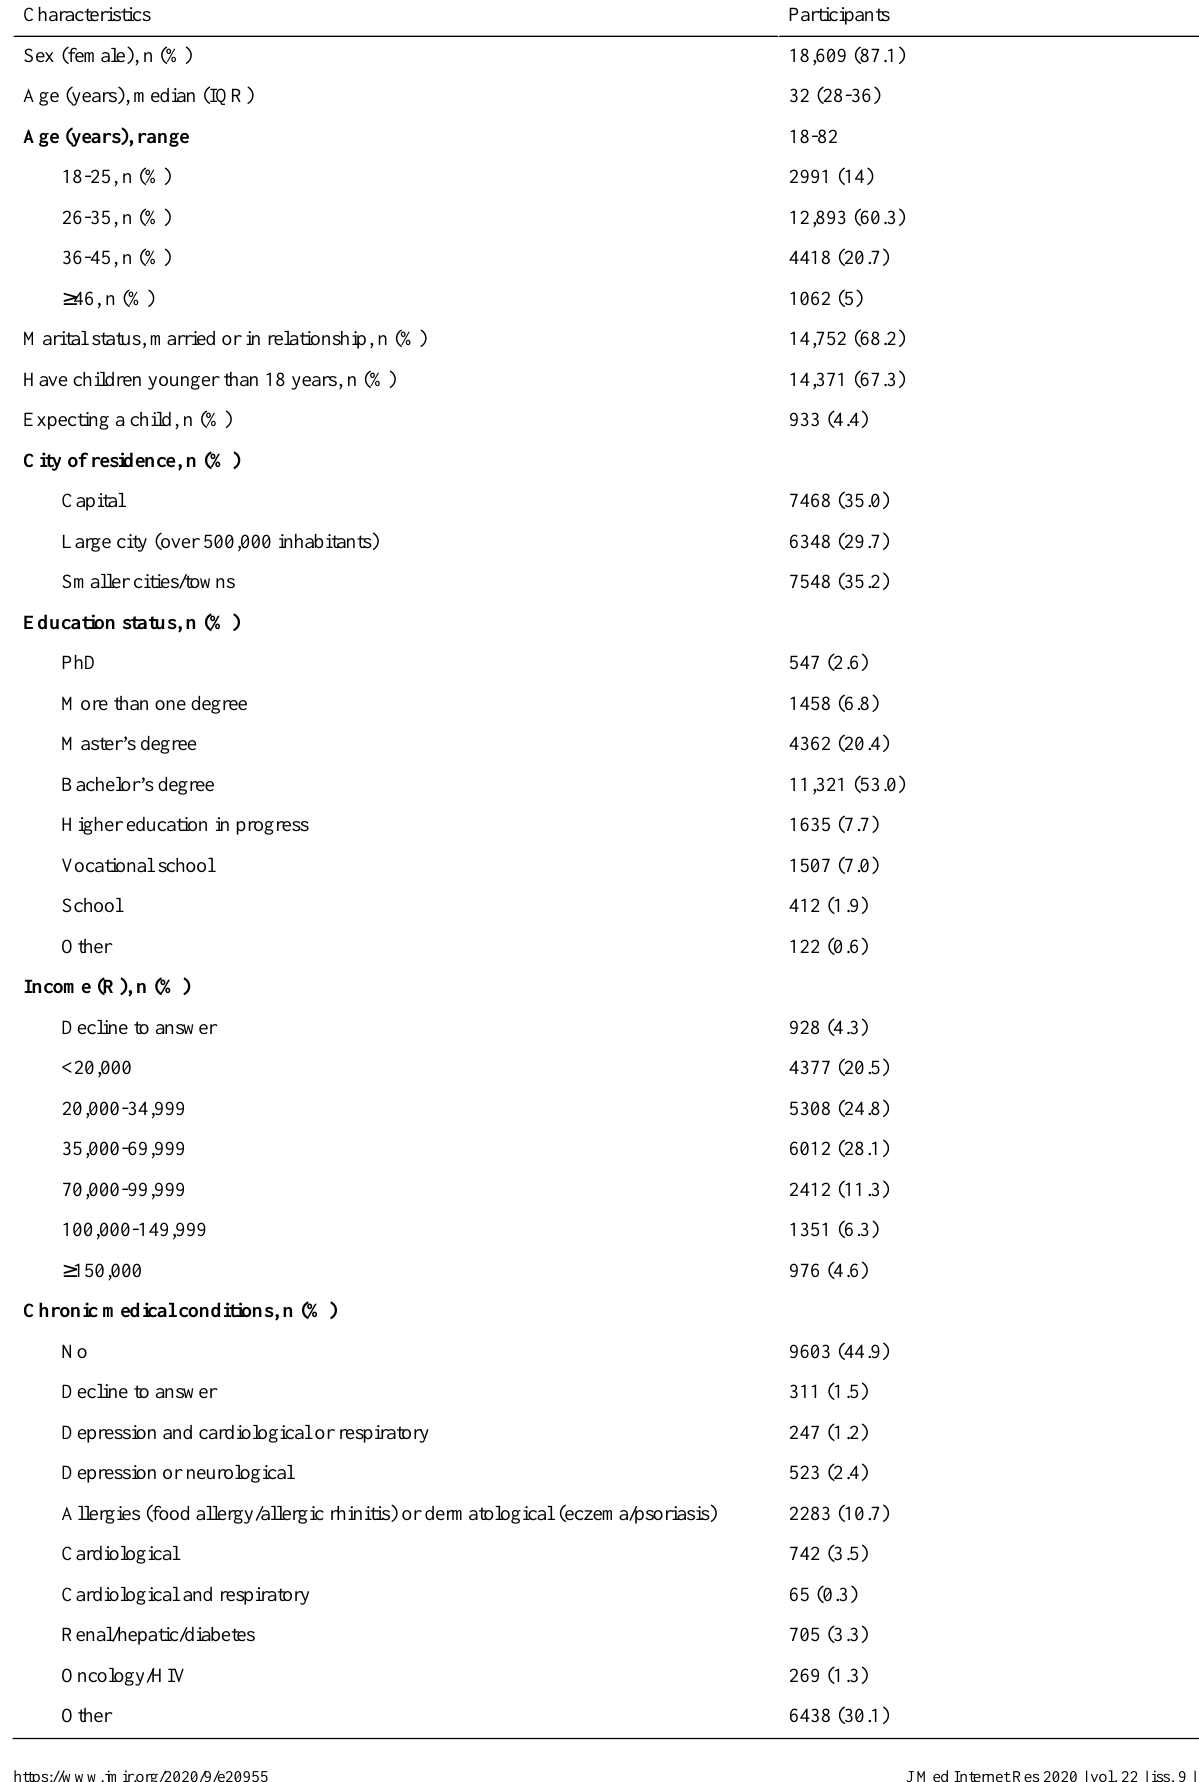
Table 1. Sociodemographic characteristics of survey respondents residing in the Russian Federation at the time of the COVID-19 pandemic (N=21,364).